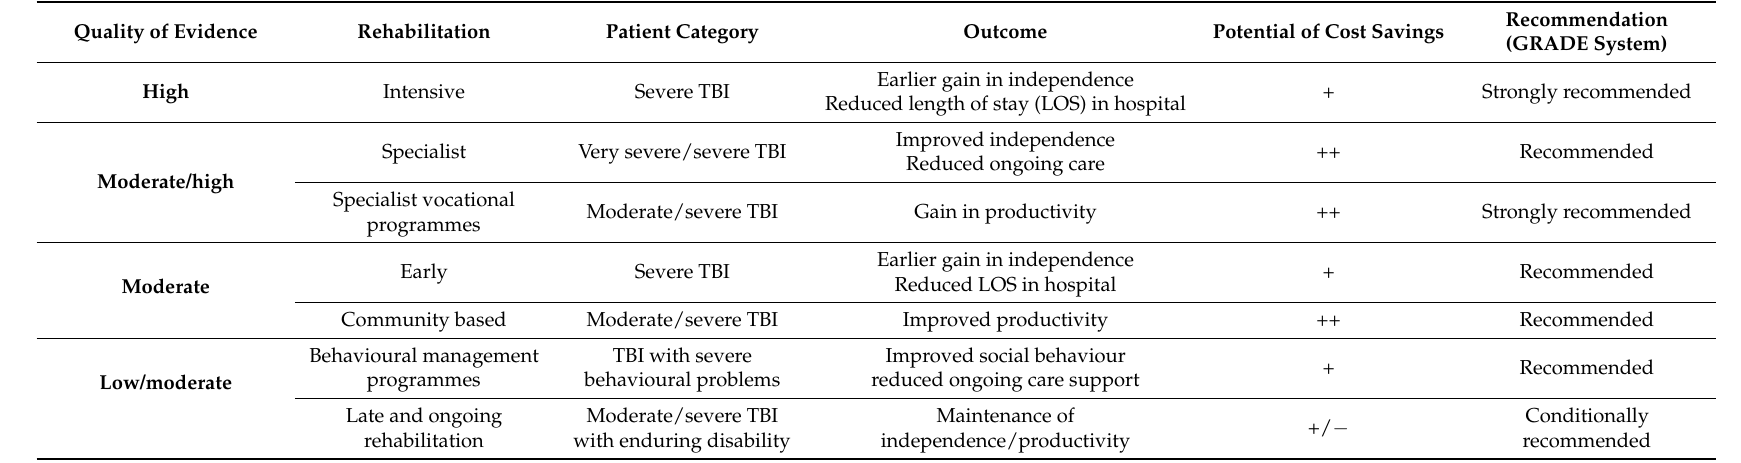
Table 1. Recommendations for clinical practice (using the GRADE system) for different neurorehabilitation approaches in TBI. TBI—traumatic brain injury; GRADE—Grading of Recommendations Assessment, Development, and